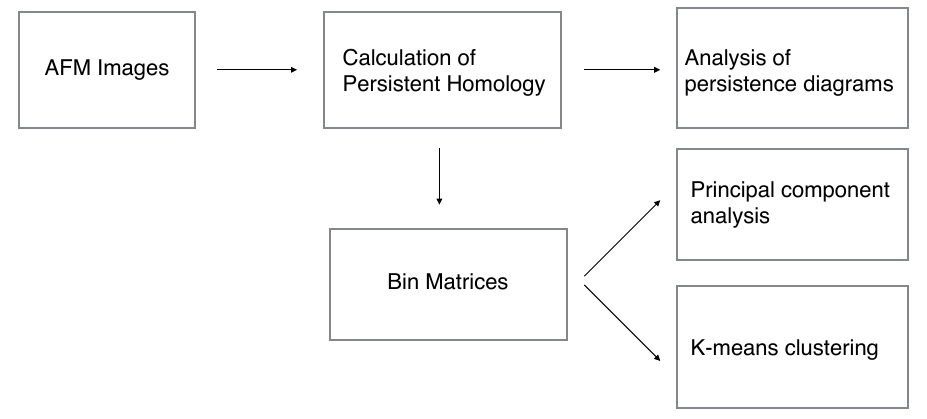
Figure 3. The flow chart of our calculation process.